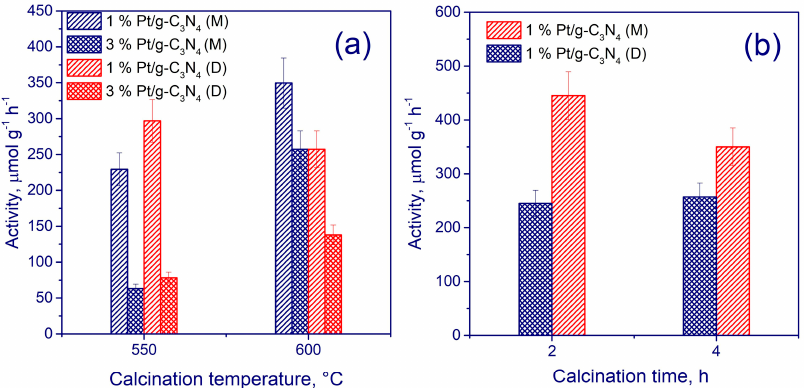
Figure 4. ( a ) Catalytic activity of samples synthesized at 550 and 600 °C for 4 h. ( b ) Catalytic activity of samples synthesized for 2 and 4 h at 600 °C using photocatalysts obtained from melamine (M) and A dicyandiamide (D). Adapted with permission from Ref. [76]. 2021, Elsevier.